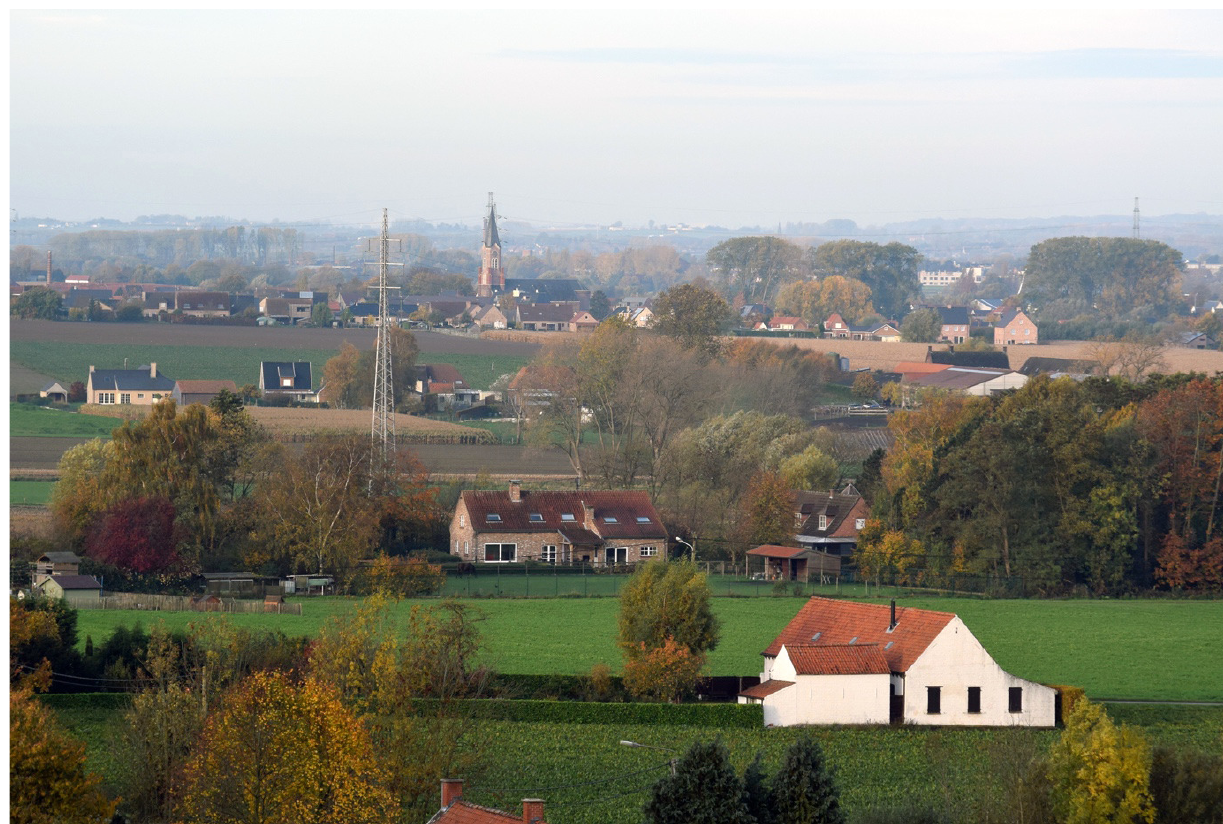
Figure 1. An urban condition that no longer coincides with the form of a “city.” This condition is built upon an ecol‐ ogy of choice enabling its inhabitants to live an urban life in diffuse settlements. Source: Photograph taken by Maarten Gheysen,